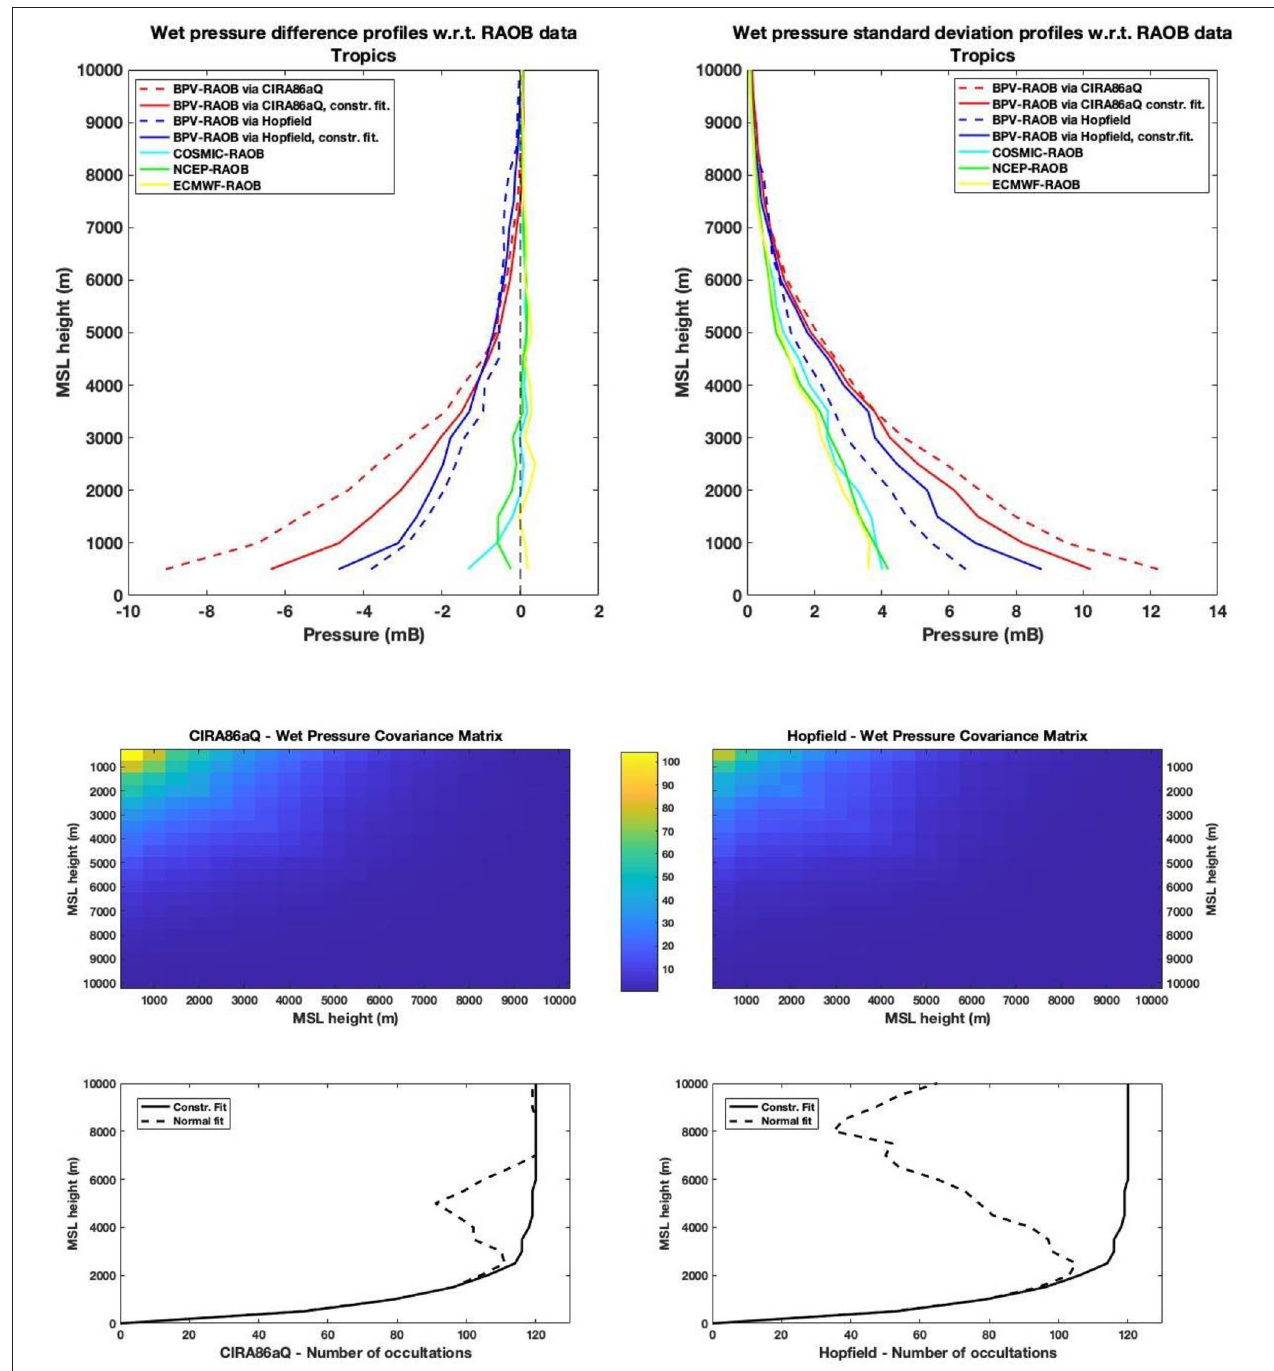
FIGURE 7 | Top: Difference (left) and standard deviation (right) profiles for the wet pressure at Tropics, with respect to the RAOB values. Middle: Covariance error matrices for the constrained CIRA86aQ case (left) and the constrained Hopfield case (right). Bottom: Number of RO observations considered, in both the constrained and unconstrained case, for the CIRA86aQ (left), and the Hopfield (right).